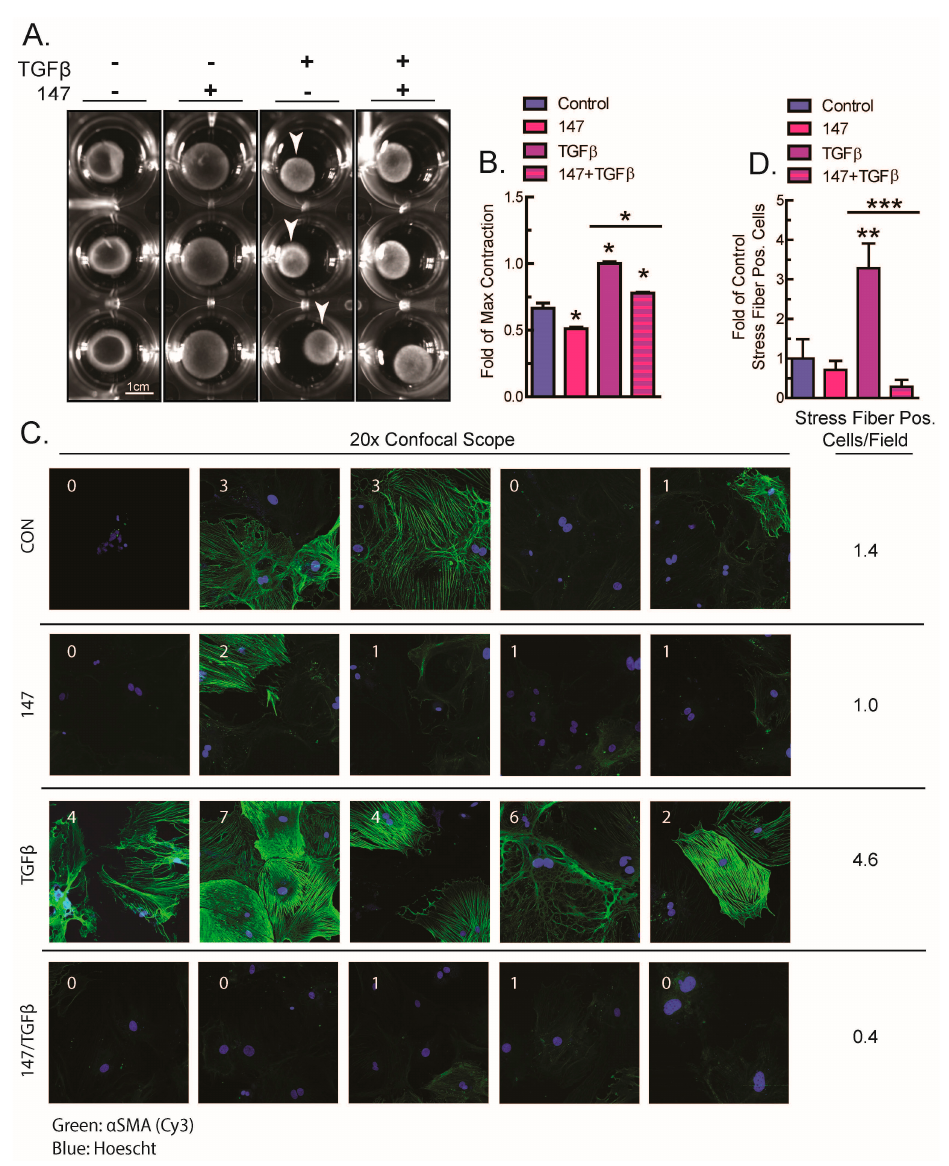
Figure 3. E ff ects of activating ATF6 on fibroblast contraction and stress fiber formation. ( A , B ) NIH 3T3 fibroblasts embedded in collagen gel disks were treated with ± 10 µ M compound 147, and then analyzed for contraction with ± 10 ng / mL TGF β after 48 h. Shown in ( A ) are examples of each culture and shown in ( B ) is the quantification of n = 3 cultures of each type, normalized to the cultures with maximum contraction (white arrows). ( C , D ) AMVFs from WT mice were treated with ± 10 µ M compound 147 and ± 10 ng / mL TGF β for 48 h, then analyzed by actin staining for stress fiber formation. All images in ( C ) were taken with a 20 × objective on a confocal microscope. In (C) the number in each field represents the number of cells that were stress-fiber positive in that field. The number to the right is the average number of stress-positive cells per field. The number of stress-positive cells per field in ( C ) is quantified in ( D ), across n = 5 fields. * p ≤ 0.05 and ** p ≤ 0.01 by one-way ANOVA. *, ** Indicate significant di ff erence between a condition and control according to Newman–Keuls post-test unless there is a line over two bars, which indicates those two bars are being compared as part of the same